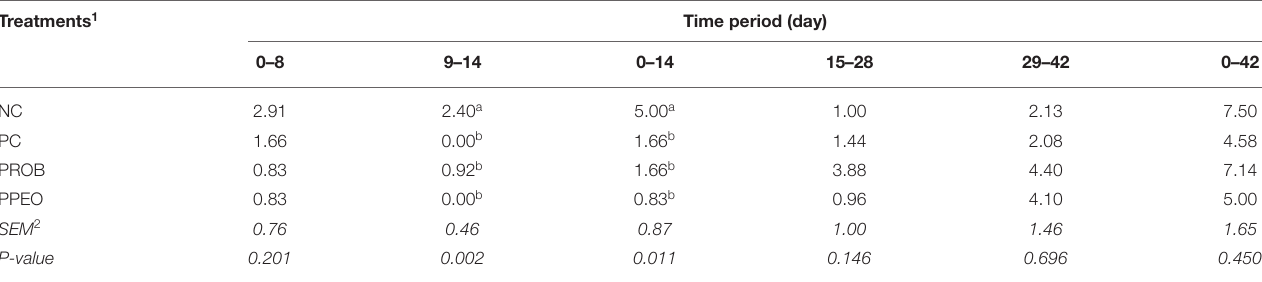
TABLE 3 | Effect of dietary probiotic (PROB) or probiotic/prebiotic/essential oil (PPEO) supplementation on mortality (%) of broiler chickens under a naturally occurring subclinical necrotic enteritis challenge. Treatments 1